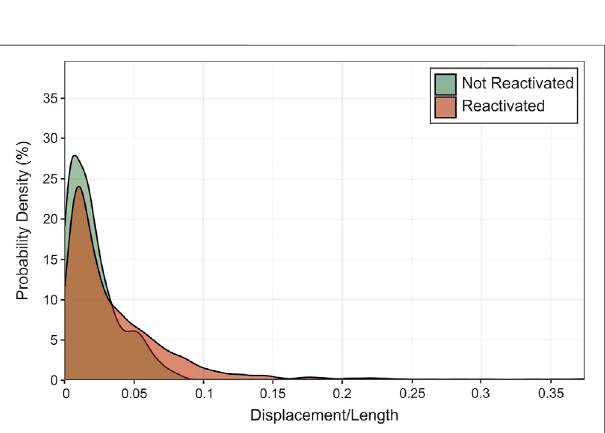
FIGURE 7 | Density estimates of the D/L value of faults that have and havenotbeenreactivatedinourdataset.PeaksinthedensityplotareattheD/ L values with the highest